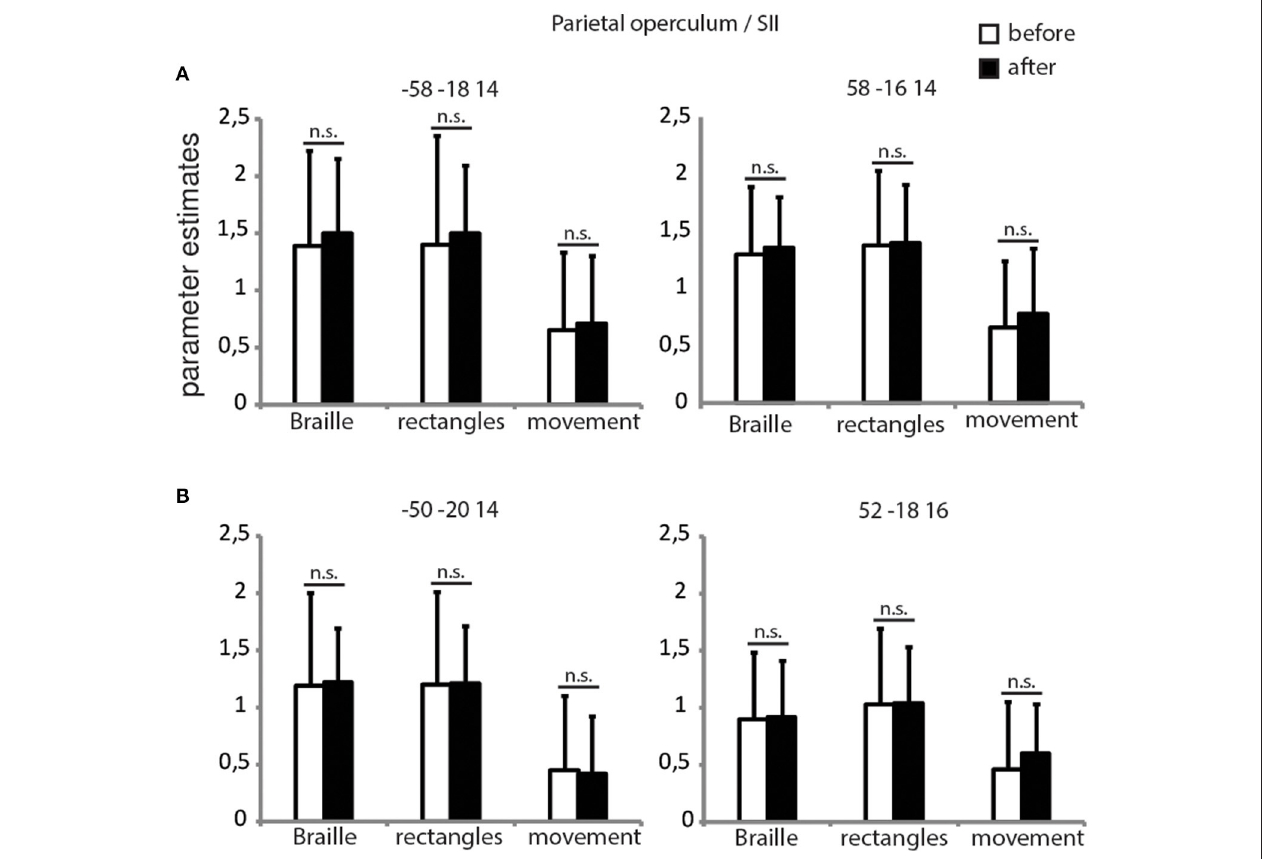
FIGURE 4 | ROI’s for parietal operculum/SII. Parameter estimates for all of the experimental conditions before and after the training in the secondary somatosensory cortex bilaterally. Coordinates for creating 6 mm spheres were chosen on the basis of our current (A) and previous study (B) . p < 0.05, corrected for multiple